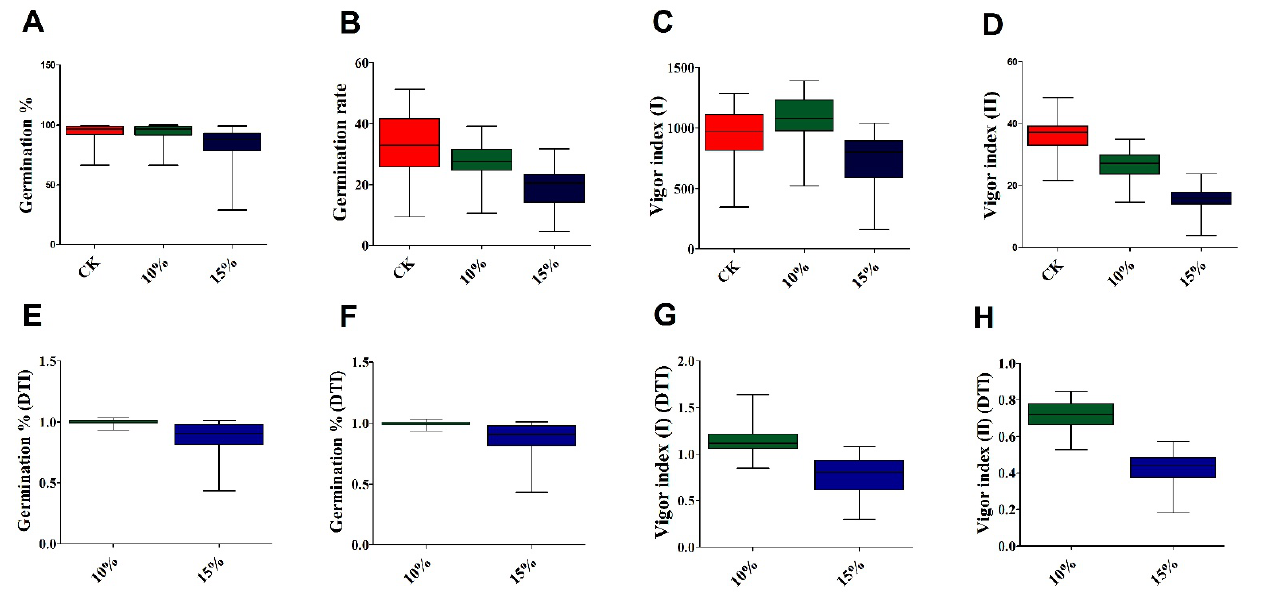
Figure 1. Box and whisker charts showing variation in germination-related traits: ( A ) final germi- nation %, ( B ) germination rate, ( C ) vigor index (I) and ( D ) vigor index (II), under CK, 10%, and 15% PEG-6000 treatments. Reduction in DTI values of ( E ) final germination %, ( F ) germination rate, ( G ) vigor index (I), and ( H ) vigor index (II) under drought stress in rapeseed seedlings. Table 1. Seed germination traits under different concentrations of PEG-6000-induced drought stress.